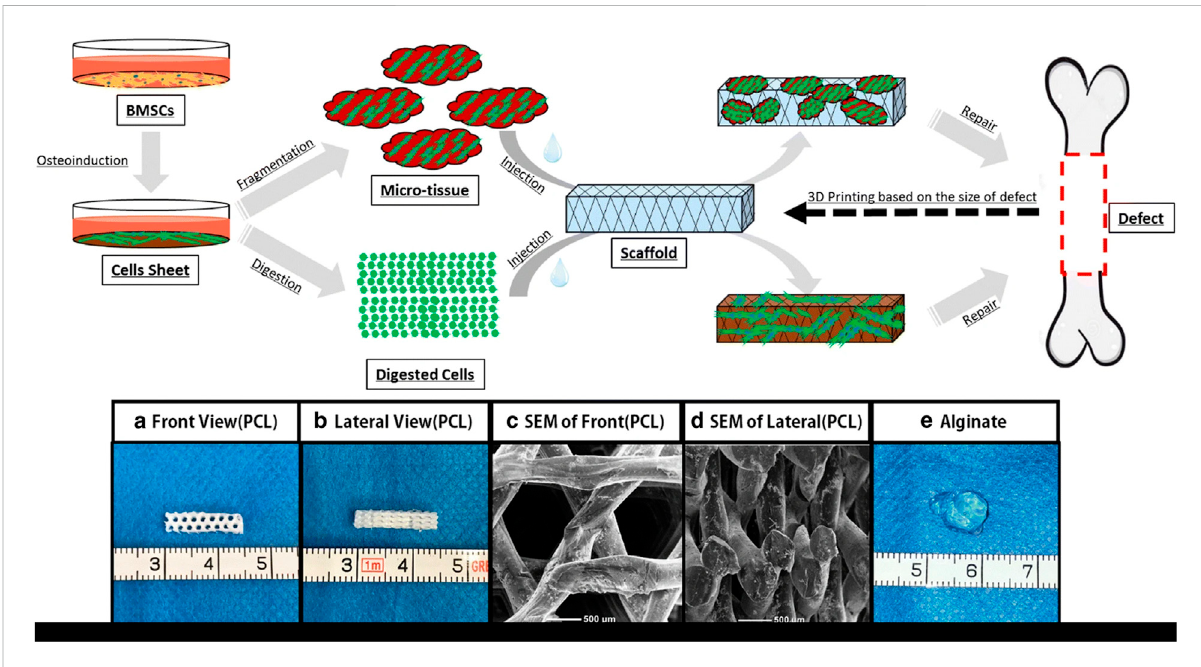
FIGURE 3 Schematic view of the micro-tissue construction procedures comparison to the digested cells. (A) Front view of Polycaprolactone (PCL) scaffold; (B) Side view of PCL scaffold; (C) A front view of PCL scaffold by electron microscope; (D) A side view of PCL scaffold by electron microscope; (E) Calcium alginate gel (General view) (Wu et al.,